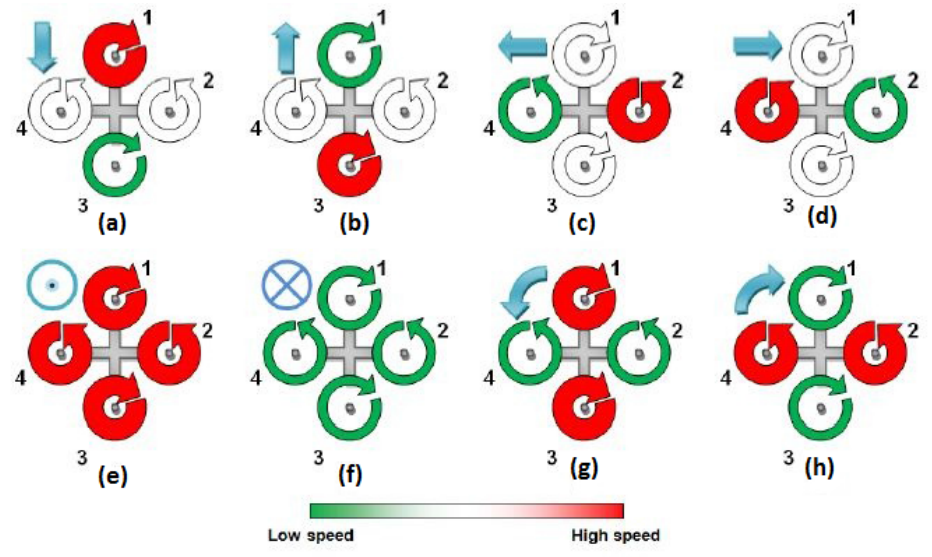
Figure 2. Quadcopter states. ( a ) Forward motion; ( b ) backwards motion; ( c ) movement left; ( d ) movement right; ( e ) increase altitude; ( f ) decrease altitude; ( g ) leftwards rotation; ( h ) rightwards